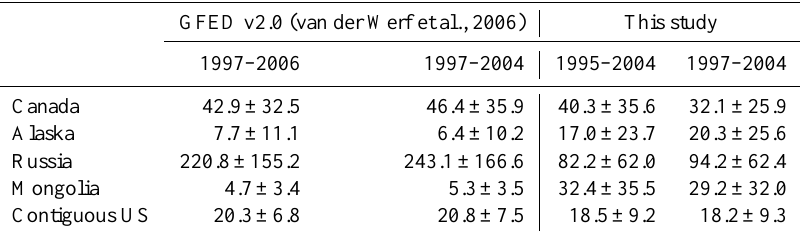
Table 3. Comparison of BC emissions from vegetation fires to Global Fire Emission Database version 2.1 for countries with the largest emissions in the boreal and temperate regions (in